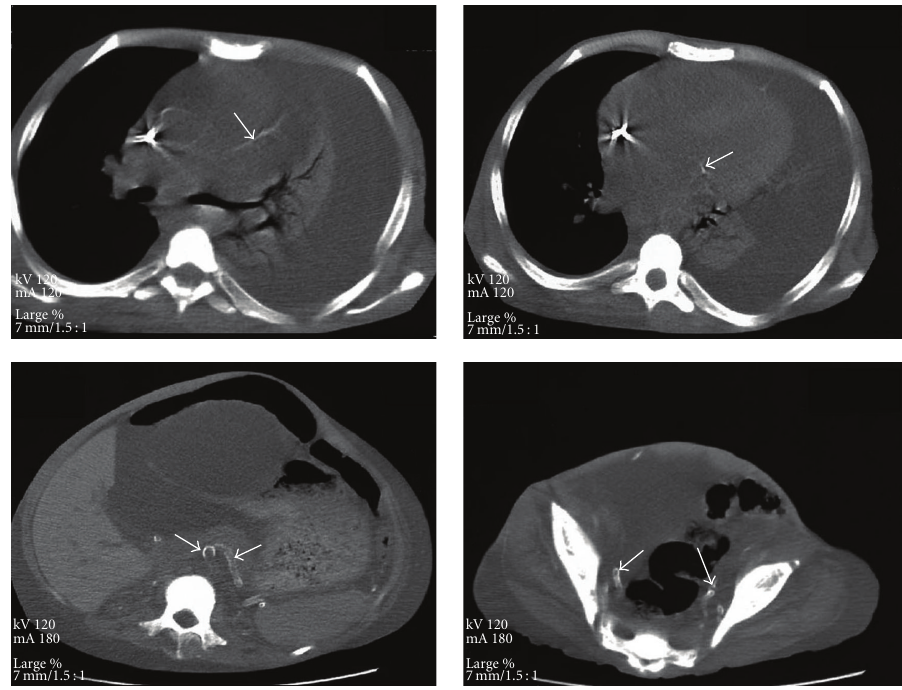
Figure 4: Axial CT sections from di ff erent levels show coronary artery, aorta, splenic, and iliac artery (arrows) calcifications. Also note pleural e ff usion, ascites, and left lung